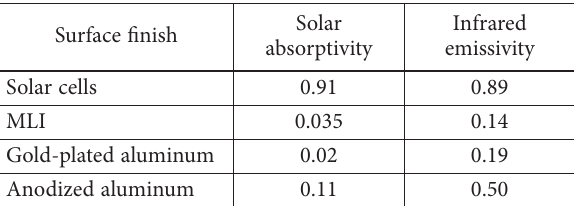
Table 2. Surface optical properties Surface